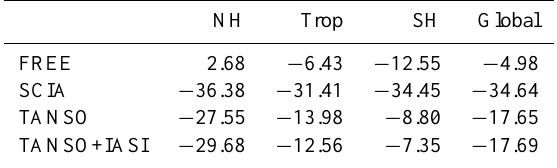
Table 1. Average difference (in ppb) between the free run or the analyses and the HIPPO data. The average is computed for the four campaigns and for data below 300hPa in height. It is also split into regions: Northern Hemisphere above 20 ◦ N (NH); tropics between 20 ◦ S and 20 ◦ N (Trop); Southern Hemisphere below 20 ◦ S (SH). NH Trop SH Global FREE